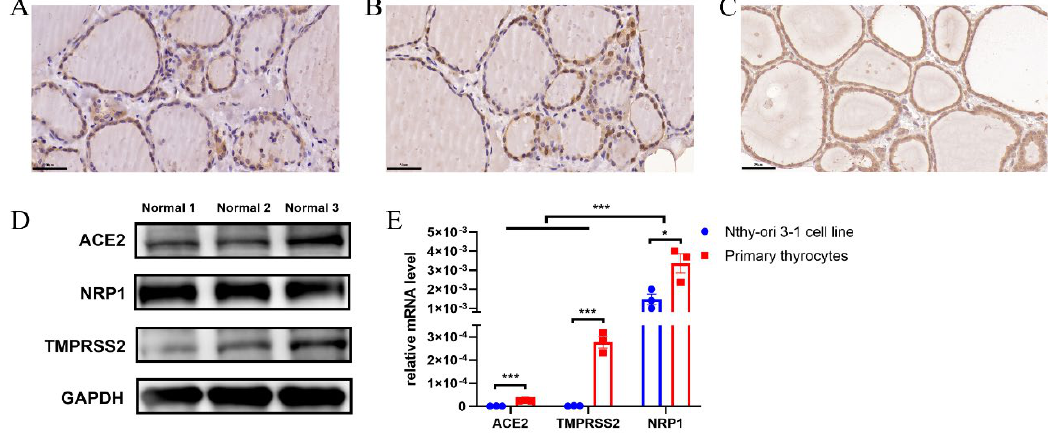
Figure 1. Expression of SARS-CoV-2 infection-mediating molecules in the human thyroid tissues. ACE2 ( A ), NRP1 ( B ), and TMPRSS2 ( C ) expression in human thyroid tissues was measured by immunohistochemical staining (IHC) (magnification, × 400). ( D ) ACE2, NRP1, and TMPRSS2 ex- pression in normal human thyroid tissues were measured by Western blot. ( E ) ACE2 , NRP1 and TMPRSS2 mRNA levels were measured by real-time PCR. The mRNA expression levels of ACE2 , NRP1 , and TMPRSS2 were significantly higher in human primary thyrocytes than in the Nthy-ori 3-1-cell line. * p < 0.05, *** p < 0.001. ACE2: angiotensin-converting enzyme 2; NRP1: neuropilin 1;